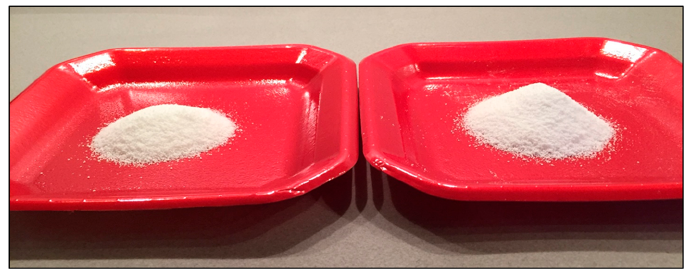
Figure 1. Visual comparison of 5.0 g (3 ½ tsp) and 7.0 g (5 tsp) of instant thickening agent.